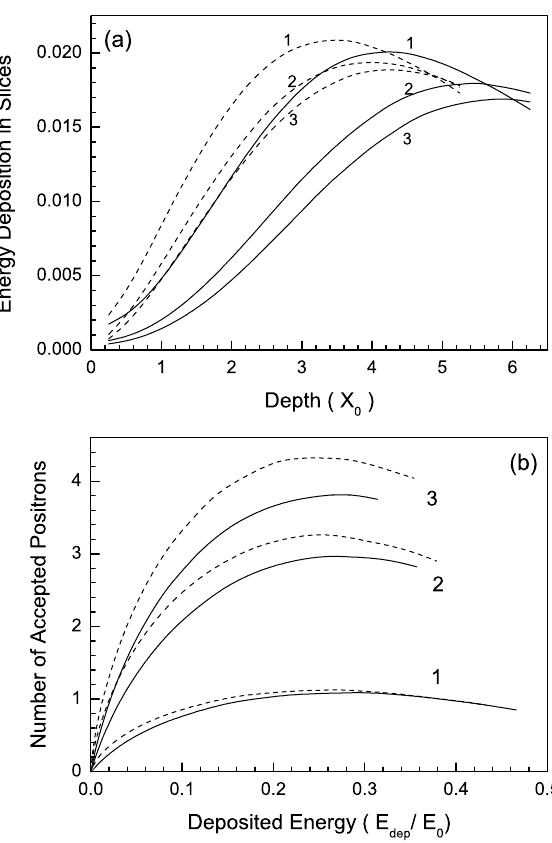
(cid:5) z (cid:6) =E targets.FIG. 3. Fraction of energy (cid:19) E deposited in z slices dep 0 (a) and number of accepted positrons as a function of the FIG. 4. (a) Mean positron energy (in MeV, upper curves) and (cid:9) 2 GeV (curves 1), =E (b) at E deposited energy E transverse momentum (in MeV =c , lower curves); (b) beam spot dep 0 0 6.2 GeV (curves 2), and 10 GeV (curves 3). Solid lines are for area development. Incoming energies are E amorphous and dashed lines for crystal (curves 1), 6.2 GeV (curves 2), and 10 GeV (curves 3). S corresponds to the incident beam. The straight line y (cid:9) 1 on (b) is drawn to guide the eye. Solid lines are for amorphous and dashed lines for crystal